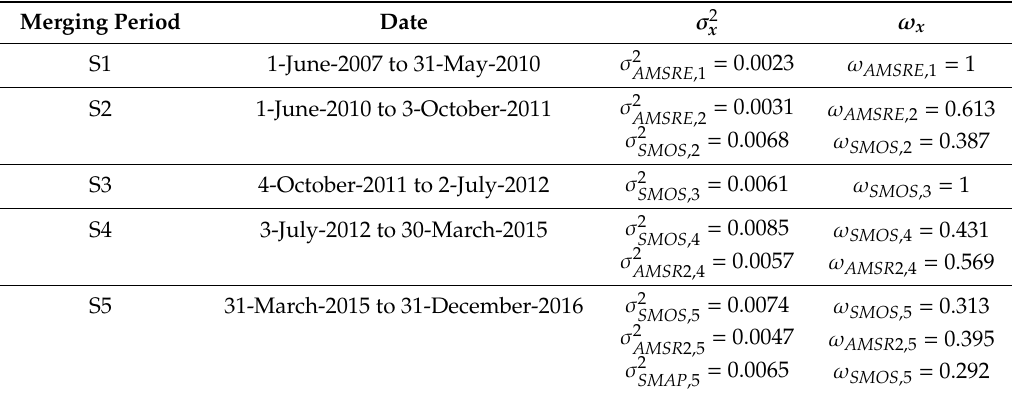
Table 2. Summary of the relative errors and optimal weights (averaged values over the entire study area) used in satellites data